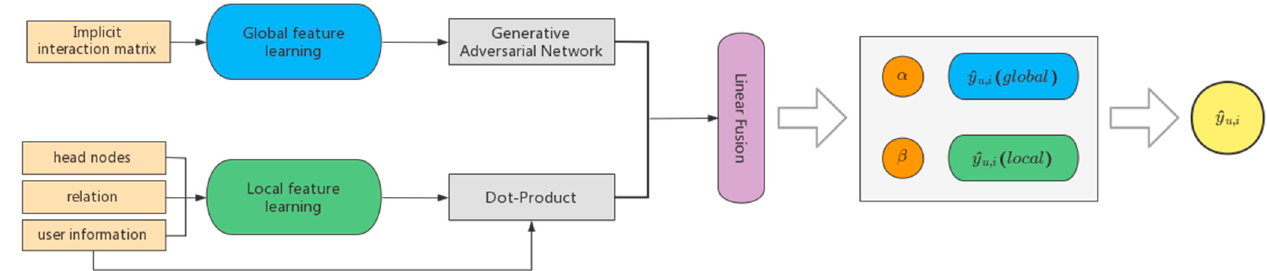
Figure 1. KGG model framework diagram.